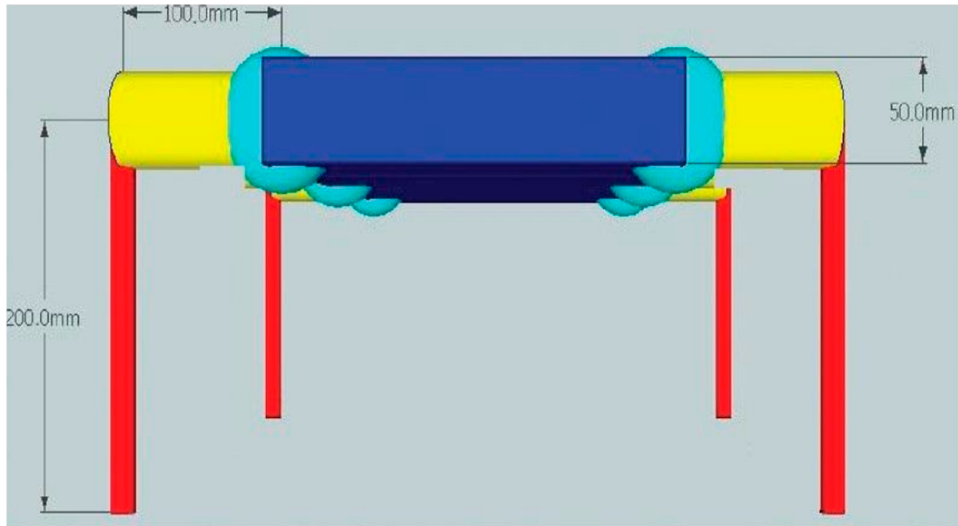
Figure 5. Front view of biomimetic mechanical dog.